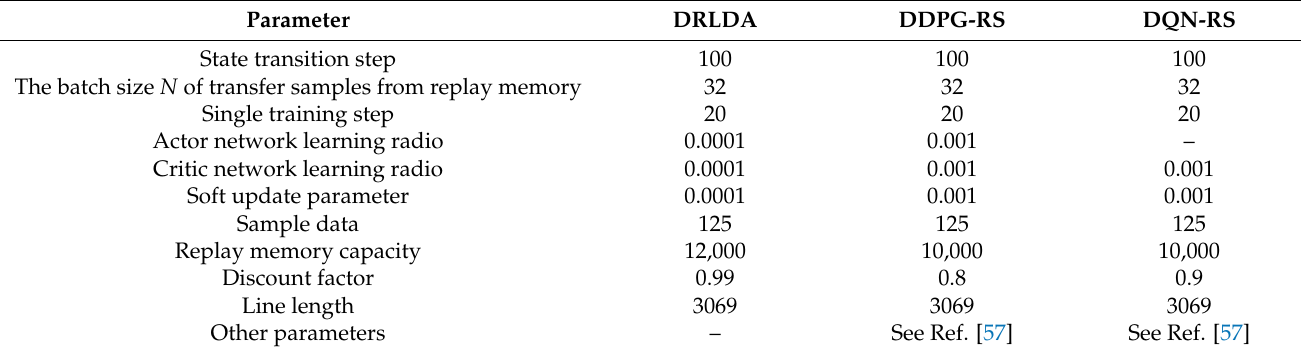
Table 7. Training parameters.